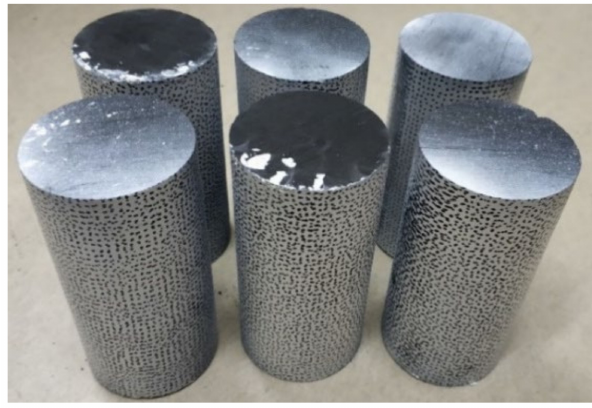
Figure 3. Some speckled specimens.